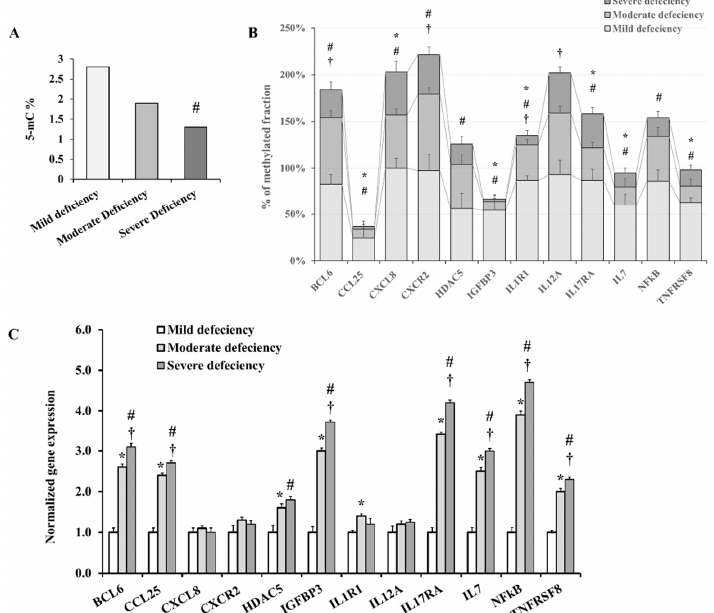
Figure 5. Adipokine promoter methylation and mRNA expression. ( A ) A bar graph showing the relative abundance of 5´-mC in DNA samples extracted from VAT samples. ( B ) A bar chart for the percentage of promoter methylation for each of the 12 differentially methylated adipokines in VAT samples. ( C ) Analysis of the relative abundance of 10 differentially expressed adipokines in VAT tissue samples using qPCR. Results are shown as means ± standard error (SE). A Significant p -Value is represented by * for comparing the mild and moderate deficiency groups, # for comparing the mild and severe de fi ciency groups, and † for comparing the moderate and severe deficiency groups. Table 3 presents a summary of the differential expression of these biomarkers, which can be classified, based on their biological function, into four groups, as follows: (1) in- Table 3. Circulating biomarkers of inflammation and vascular